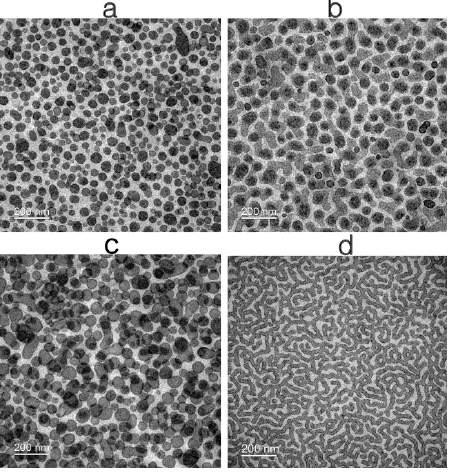
Figure 3. Transmission electron microscopy (TEM) images of the prepared block copolymers: ( a ) entry 1, ( b ) entry 3, ( c ) entry 5 (Table 1), and ( d ) commercial-grade PS- block -poly(ethylene- co -1-butene)- block -PS (SEBS).